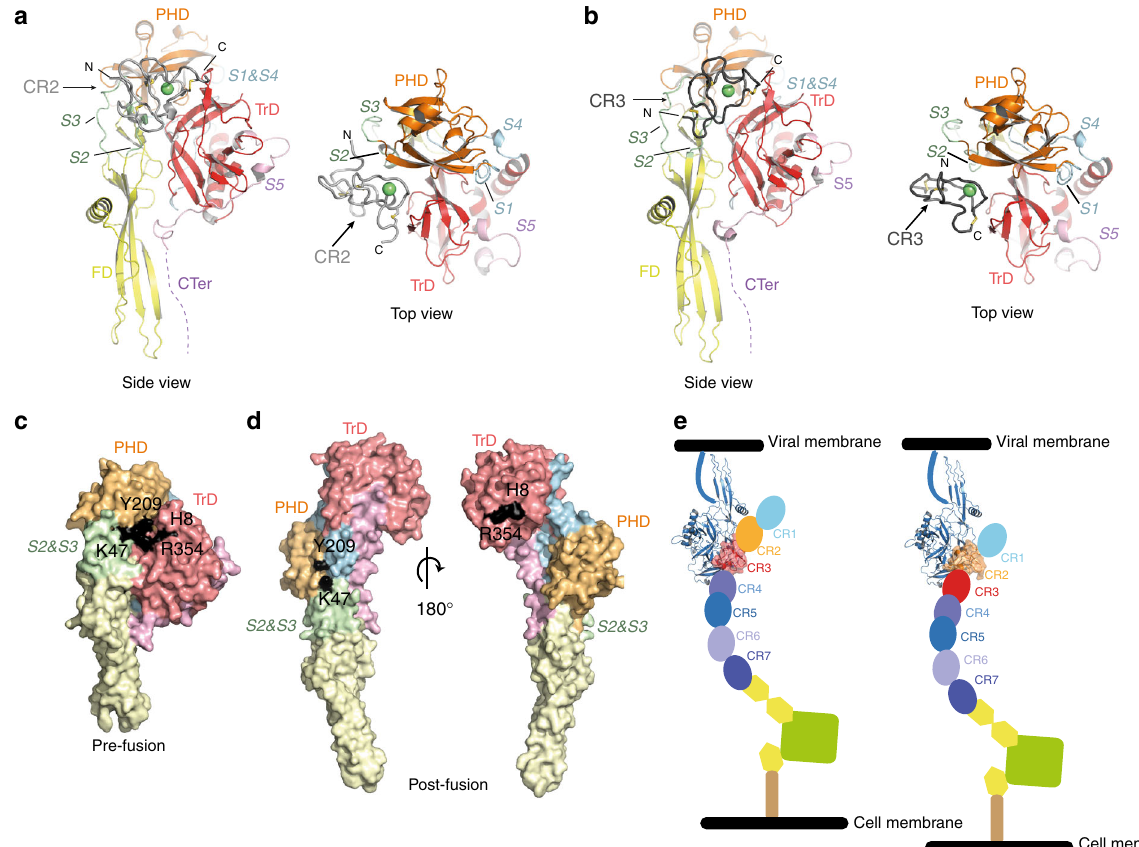
Fig. 3 X-ray structures of G th -CR2 and G th -CR3 complexes a , b Overview of G th CR2 ( a ) and G th CR3 ( b ) crystalline structures in ribbon representation. G is depicted by domains and CR domains are in two shades of gray. The conserved disul fi des bonds of each CR that maintain their secondary structure are in yellow. In both complexes the CR domain is nested in the same cavity of G. N and C-terminal extremities of each CR are indicated. Color code for G th : the trimerization domain (TrD) is in red, the pleckstrin homology domain (PHD) is in orange, the fusion domain (FD) is in yellow. Those domains are connected by segments (S1 to S4) which refold during conformational change: segments S1 and S4 are in cyan, segments S2 and S3 are in green, S5 and the C- terminal segment (CTer) are in purple. The calcium ion of the CR domains is depicted as a green sphere. c Footprint of CR2 domain on G pre-fusion conformation. G is in full atoms view and depicted by domains. Residues of G that establish contacts with CR are shown in black on the surface of the protein. d Location of residues interacting with CR domains on G post-fusion conformation. Two views at 180° are shown. Note that the interaction patch is scattered when G is in this conformation. e Scheme showing the two complexes that can be formed between VSV G and LDL-R. At the cell surface, at neutral pH, the LDL-R adopts an open extended conformation 19 and VSV G can bind either CR2 or CR3. Note that the LDL-R in this extended conformation has the appropriate orientation to interact with G anchored in the viral